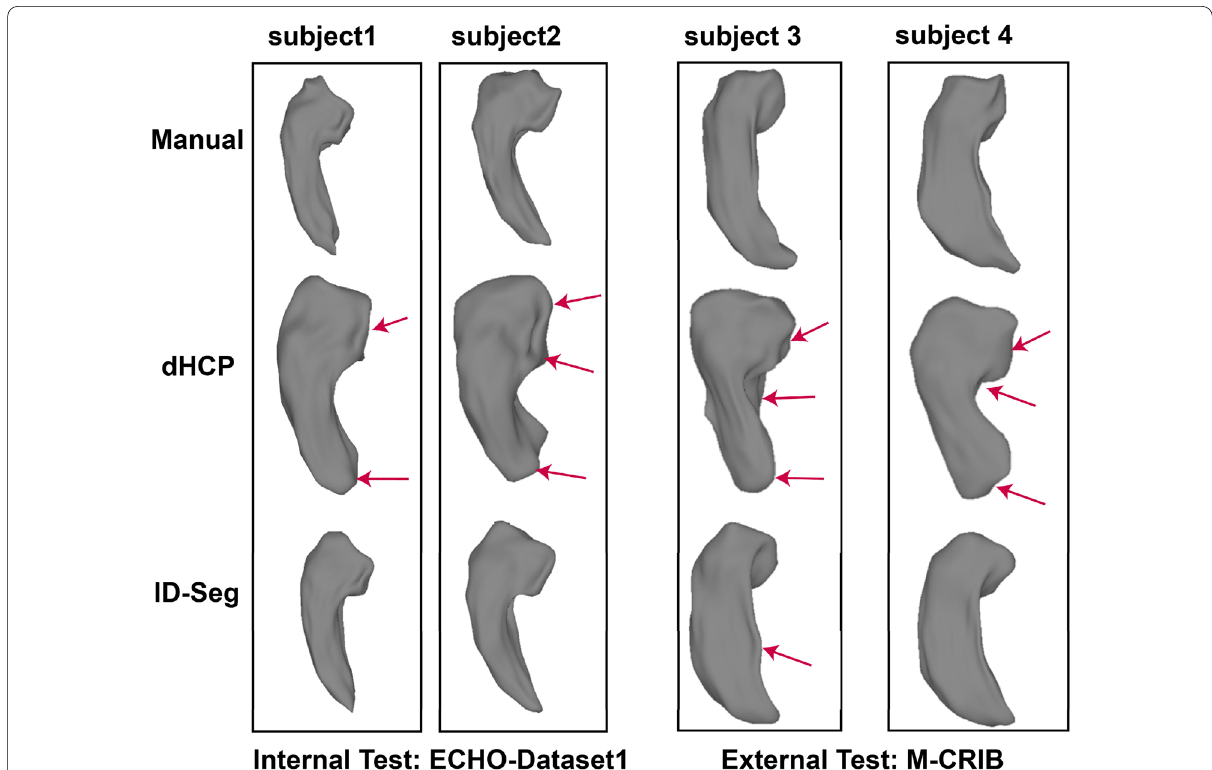
Fig. 2 Visual comparisons between the “ground-truth” manual, dHCP, and ID-Seg segmentations for the left hippocampus’s 3D shape using our internal (ECHO-Dataset1) and external (M-CRIB) datasets, respectively. Red arrow highlights the areas with notable differences